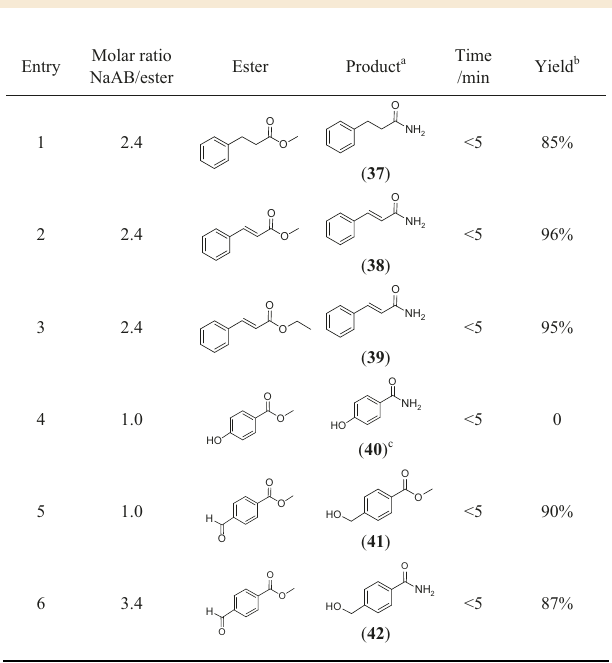
Table 2 The reactions of NaAB and esters with other functional